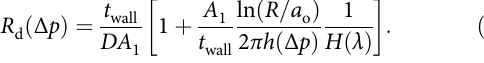
Fig. 2 Schematic of PD pore geometry. a The structure is characterized by the cell wall thickness t wall , pressure-dependent inlet gap height h ( Δ p ), inlet gap radius R , desmotubule radius a i , PD pore radius a o , and the cytoplasmic sleeve thickness w . b Section view of the PD, highlighting the annular pore structure. See legend in Fig. 1 and details in